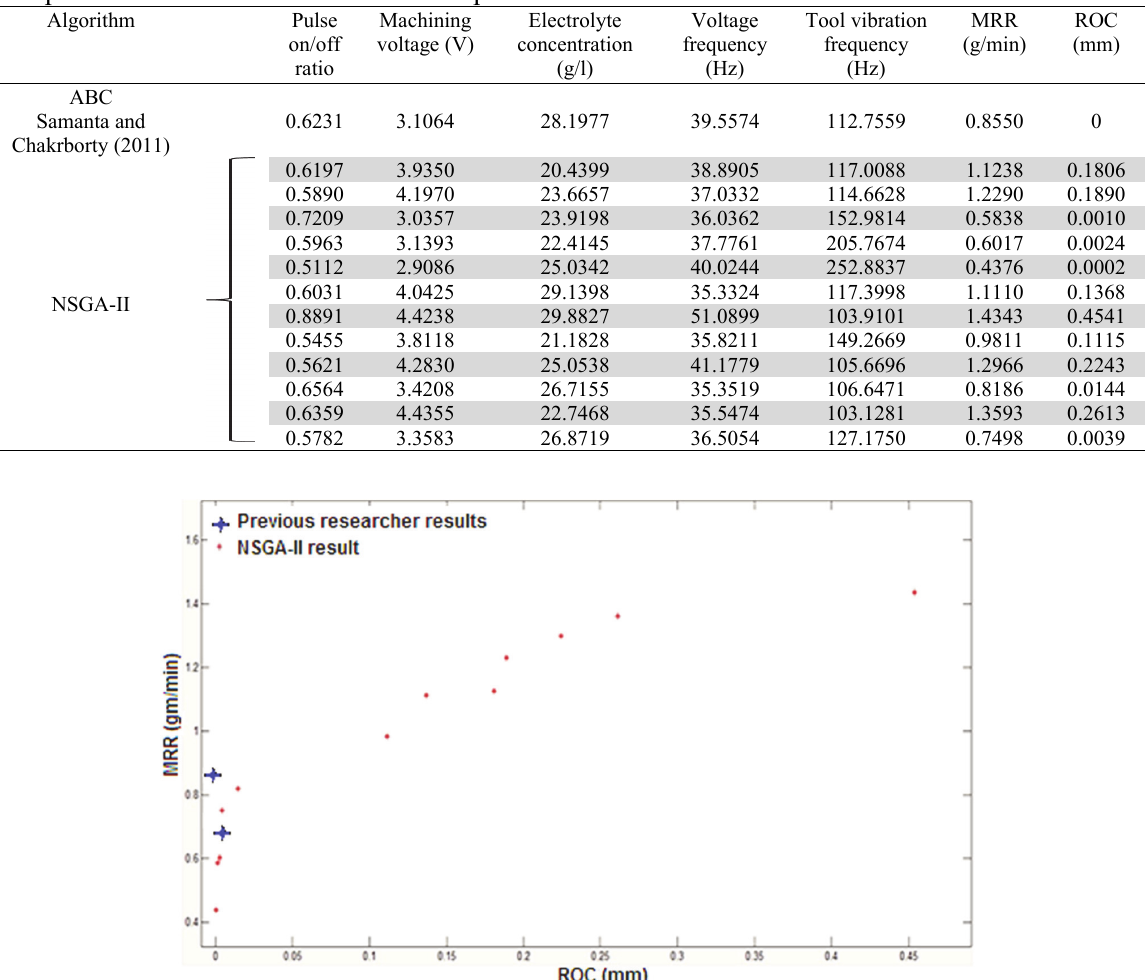
Fig. 2 Pareto optimal front and comparison of result for EMM